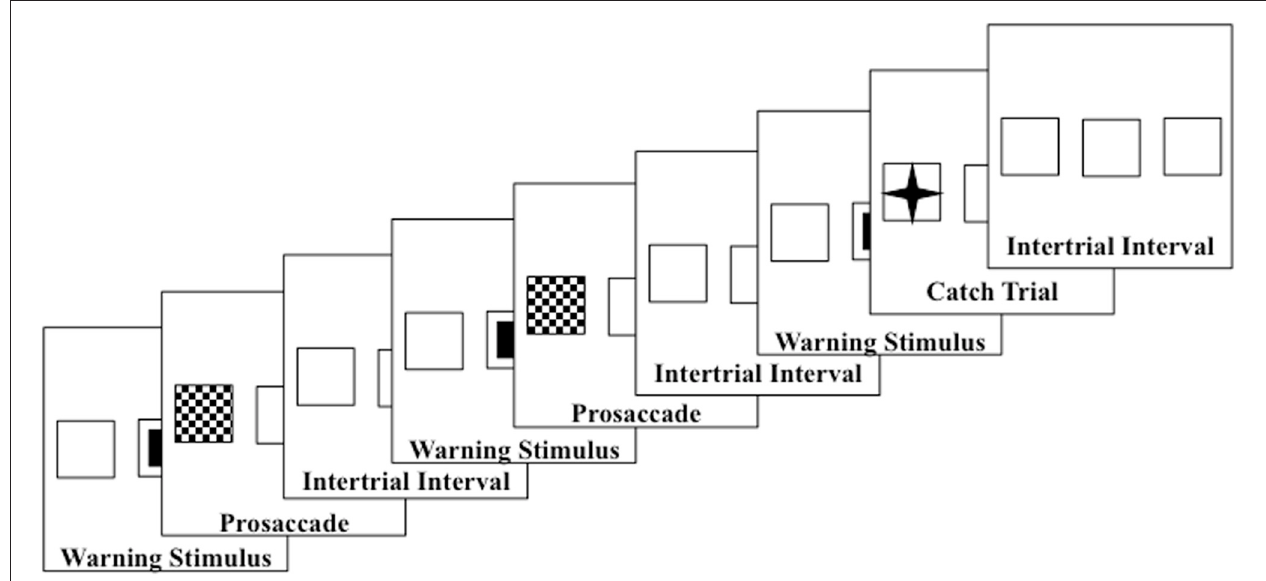
FIGURE 7 | An example blocked trials presentation sequence. The sequence shows the blocks of uncued prosaccade